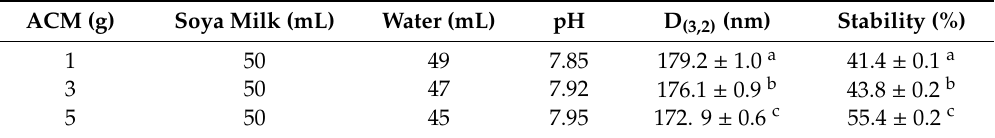
Table 3. E ff ect of ACM on the stability of soya milk